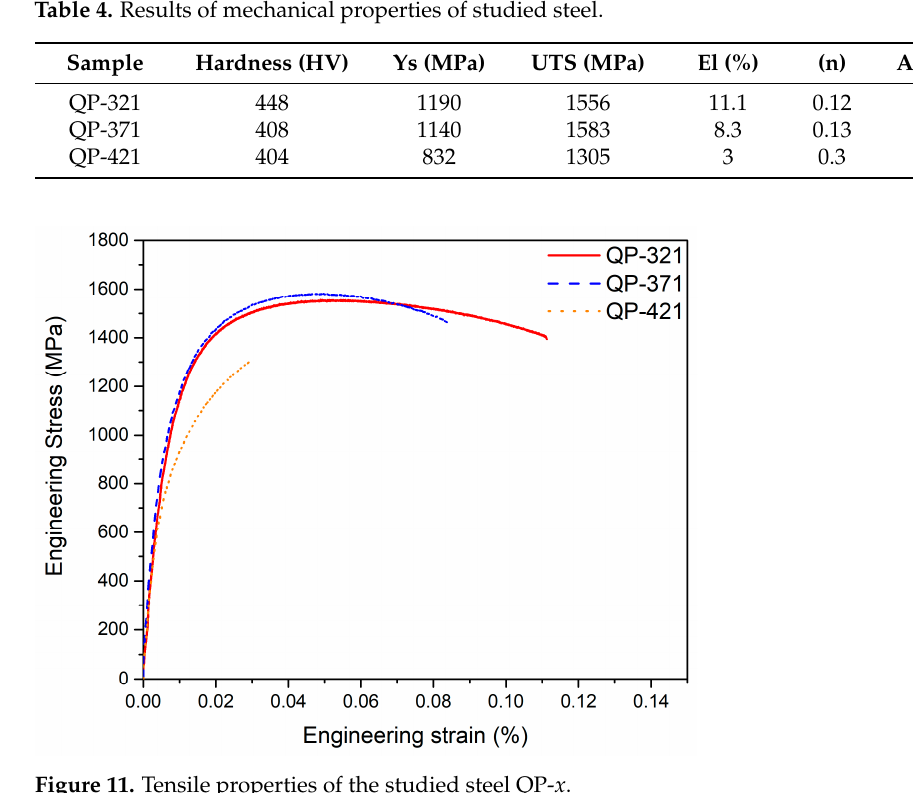
Figure 11. Tensile properties of the studied steel QP- x .